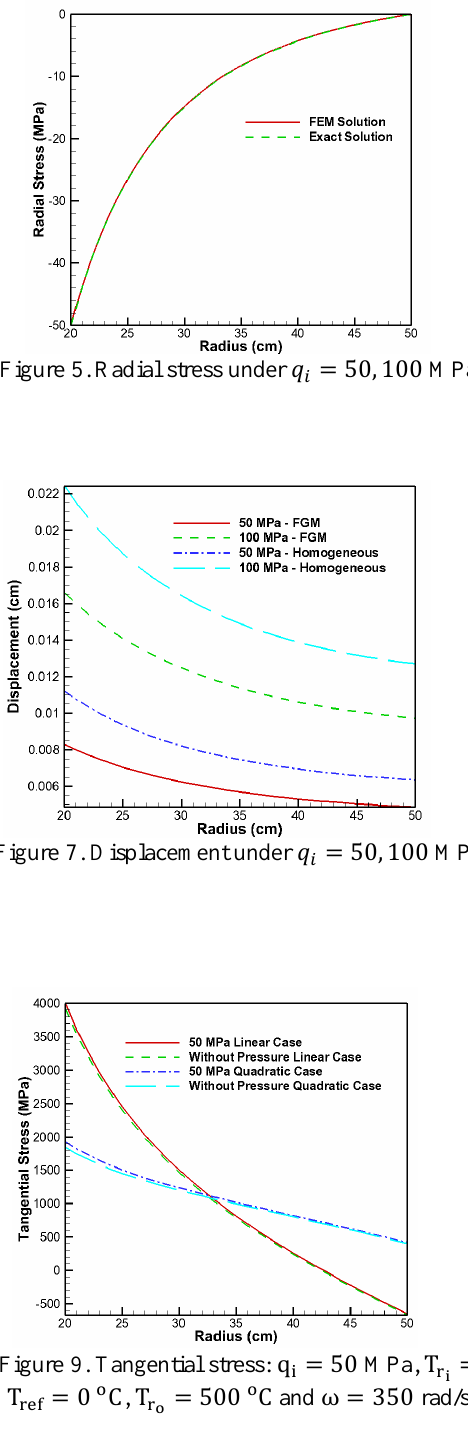
= 500 o C and ω = 350 rad/s r o